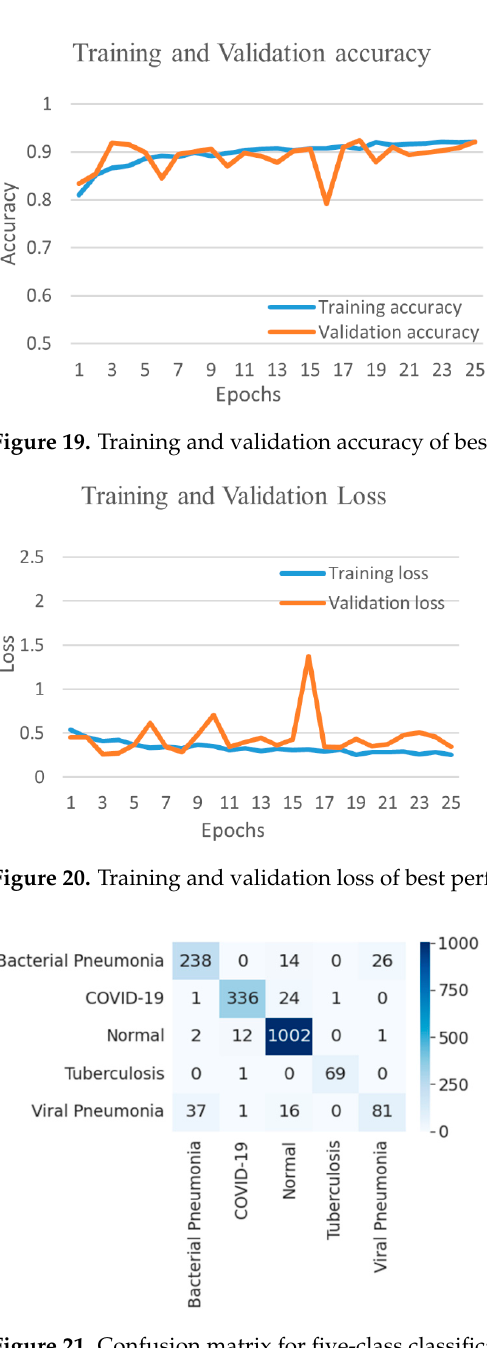
Figure 21. Confusion matrix for five-class classification by VGG16.